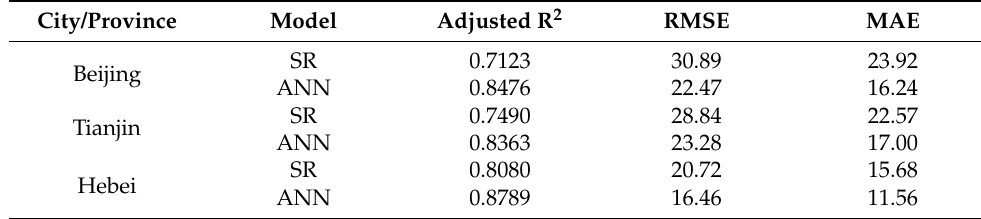
Table 4. Performance of O 3 concentration simulation using SR and ANN models.